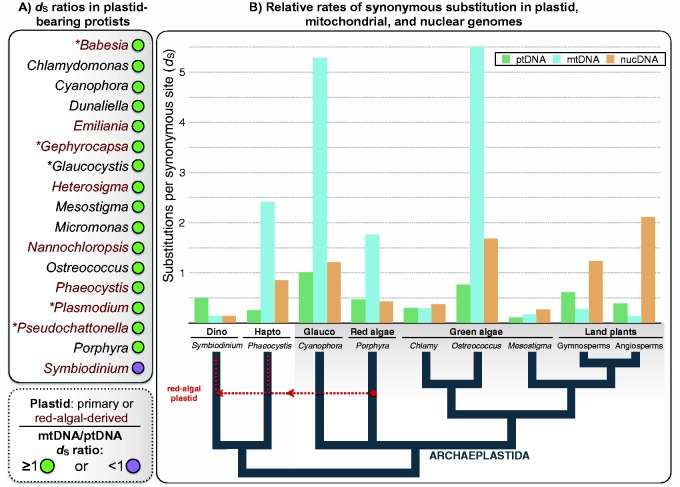
Relative rates in plastid-bearing protists. (A) The relative rate of synonymous substitutions in mitochondrial versus plastid genomes (dS ratio) for various plastid-bearing protists. An mtDNA/ptDNA dS ratio of ≥1 is shown with a green circle and <1 with a purple circle. (B) Synonymous substitution rates in plastid, mitochondrial, and nuclear genomes. ptDNA is shown in green, mtDNA in blue, and nucDNA in orange. The Archaeplastida comprises glaucophytes (Glauco), red algae, green algae, and land plants, all of which have primary plastids. The haptophyte (Hapto) Phaeocystis and the dinoflagellate (Dino) Symbiodinium have secondary, red–algal-derived plastids. The methods used to estimate dS and the number and type of loci investigated sometimes differed among the various taxa. The ML approach was used to estimate dS for all taxa without an asterisk in front of their names. Alternative methods were used for those with an asterisk (see Materials and Methods).